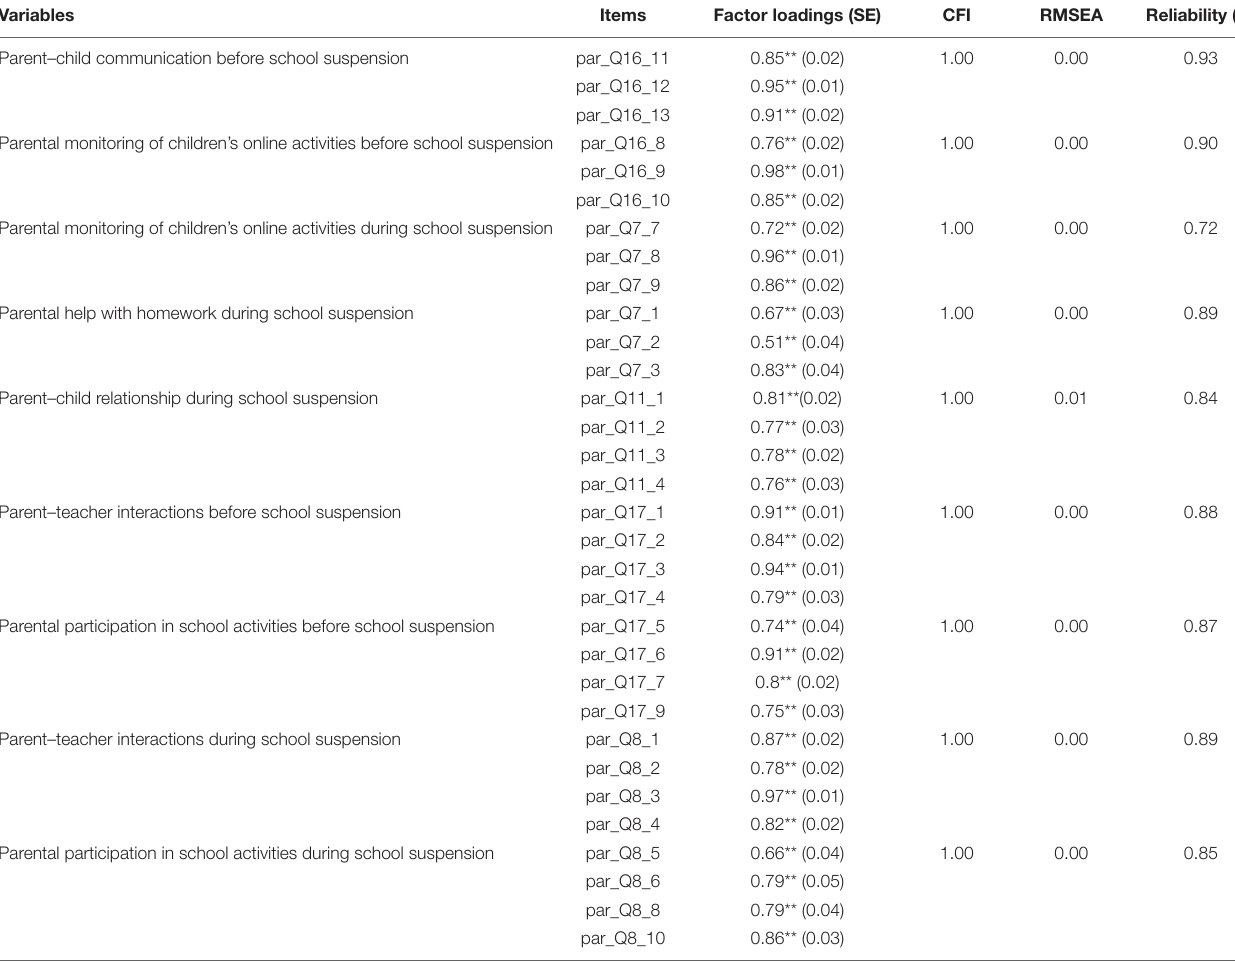
TABLE 2 | CFA for parenting variables (secondary schools). Variables Items Factor loadings (SE) CFI